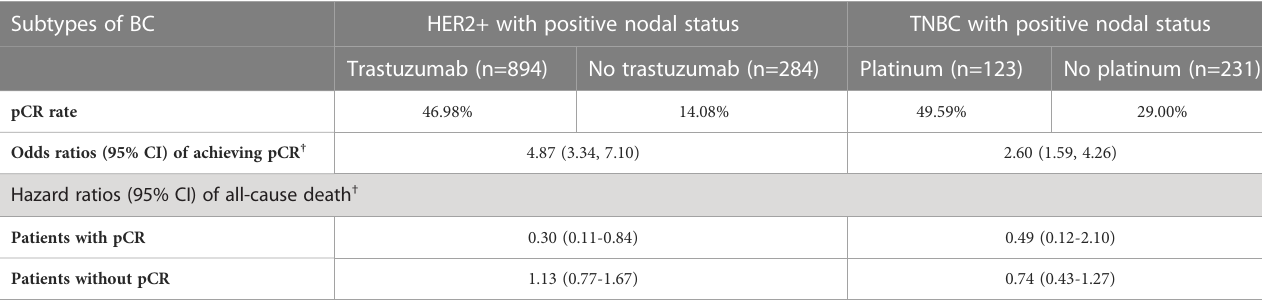
TABLE 2 Treatment-associated odds ratios of achieving pCR and hazard ratios of all-cause death (reference case: no treatment)*. Subtypes of